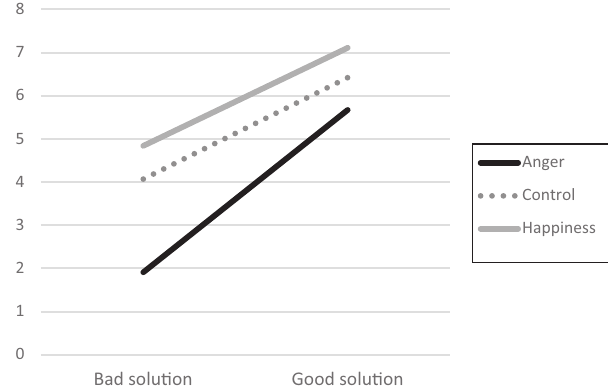
Figure 3. Customer ’ s